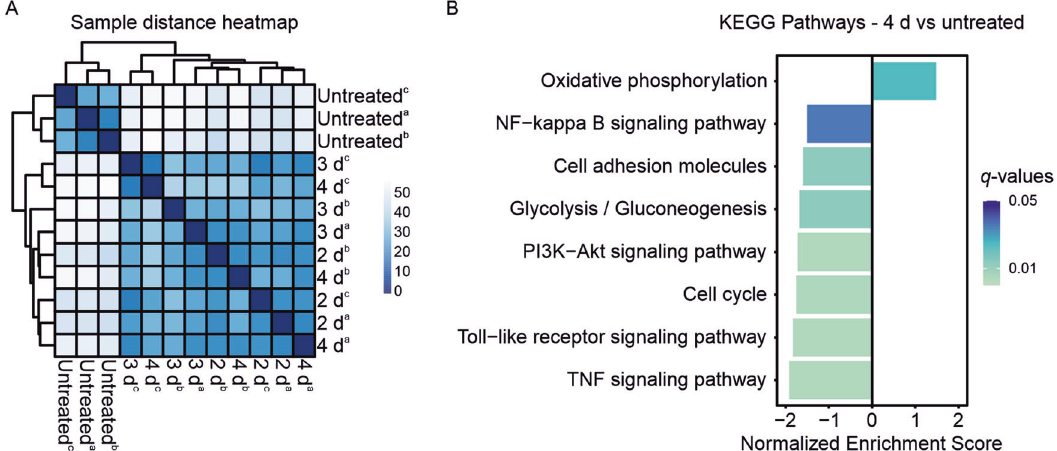
Fig. 1 RNA-seq of REC-1 during ibrutinib treatment. A Heatmap showing sample-to-sample distances of untreated and ibrutinib-treated (2 d, 3 d, 4 d) samples of three independent replicates (a, b, c) based on the variance stabilizing transformed values. B Selected signi fi cant pathways (|log2FC | ≥ 1, q -value < 0.05) of 4 d ibrutinib-treated REC-1 (vs untreated) from Kyoto Encyclopedia of Genes and Genomes (KEGG) pathway gene set enrichment analysis